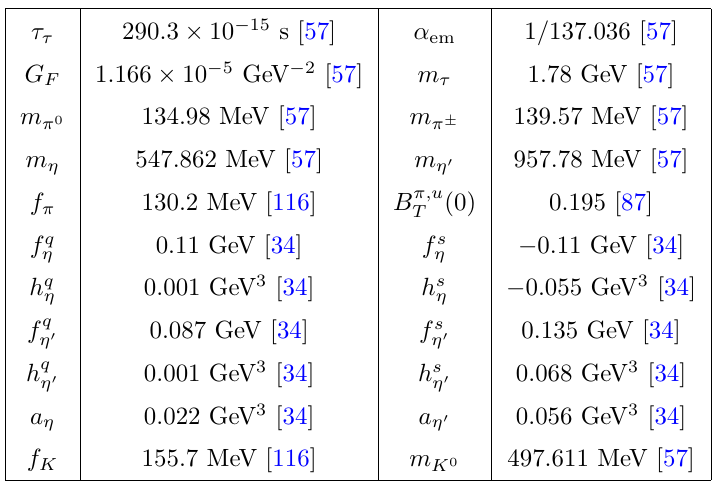
Table 25 . Input parameters for τ